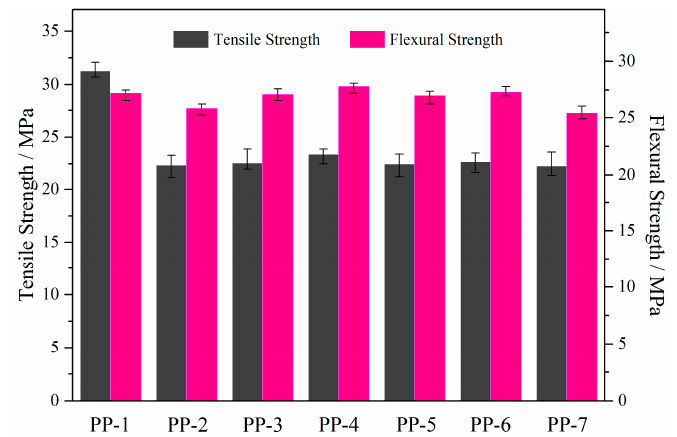
Figure 4. Tensile and flexural strength of PP and its composites.